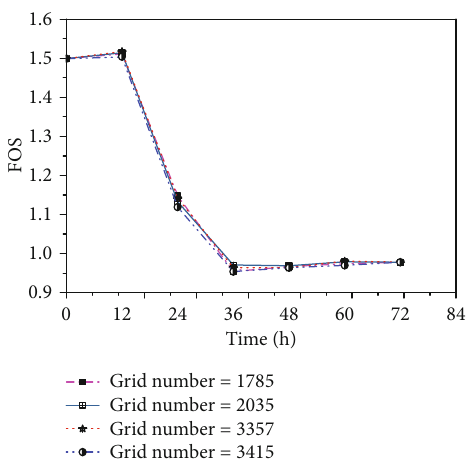
Figure 5: Comparison between numerical results and experimental